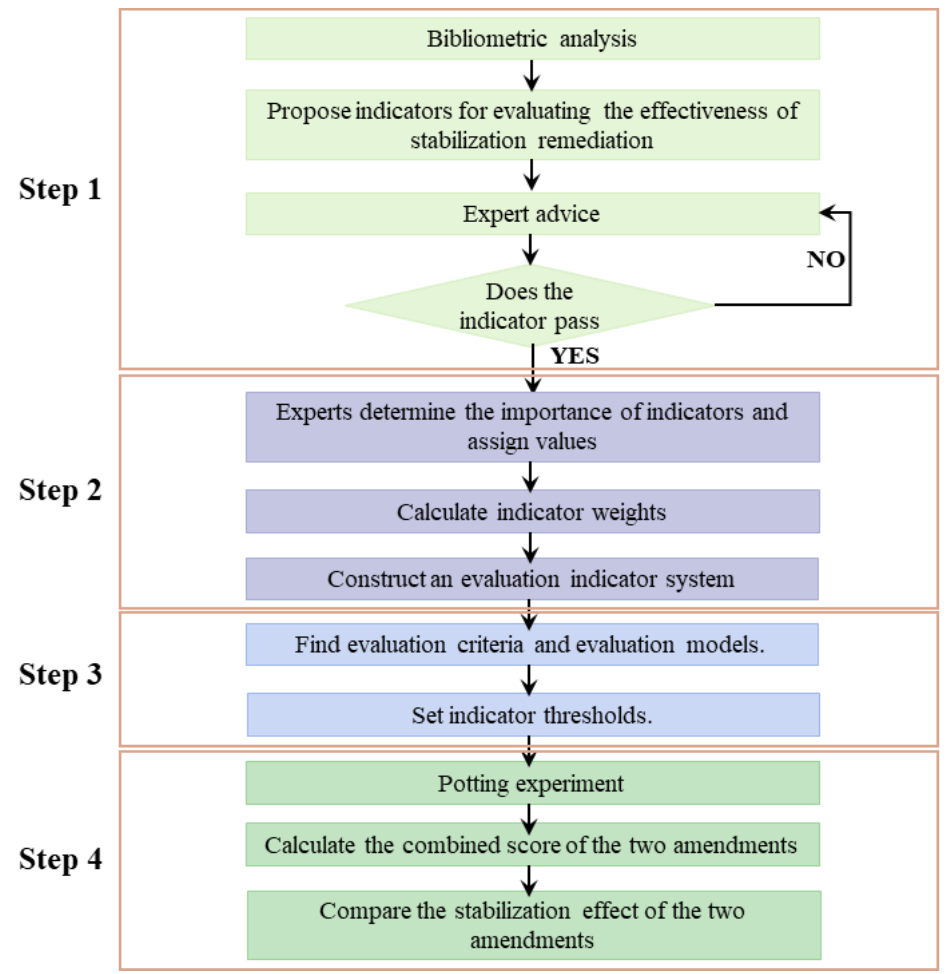
Figure 1. Technology Roadmap.